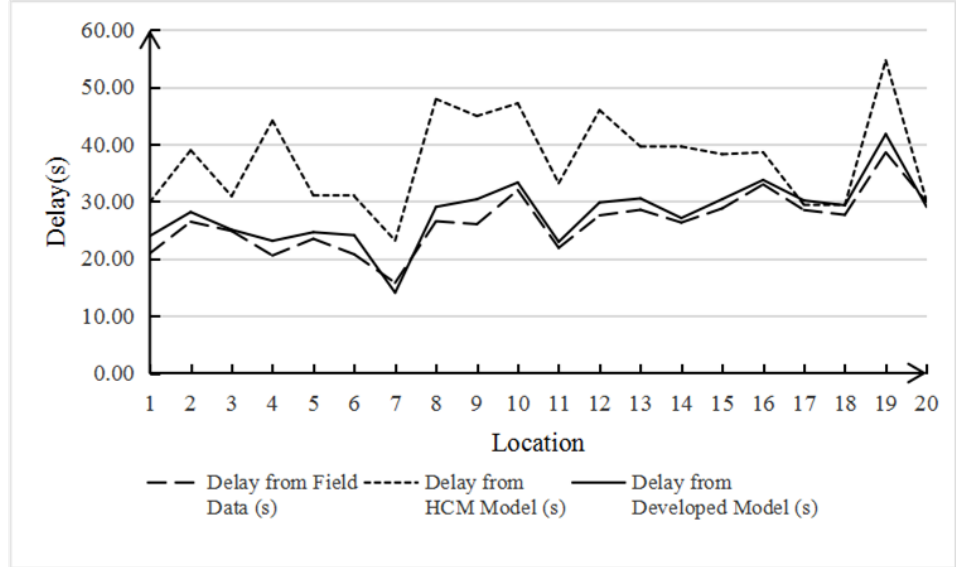
Figure 4. Comparative analysis of the non-motorized vehicle